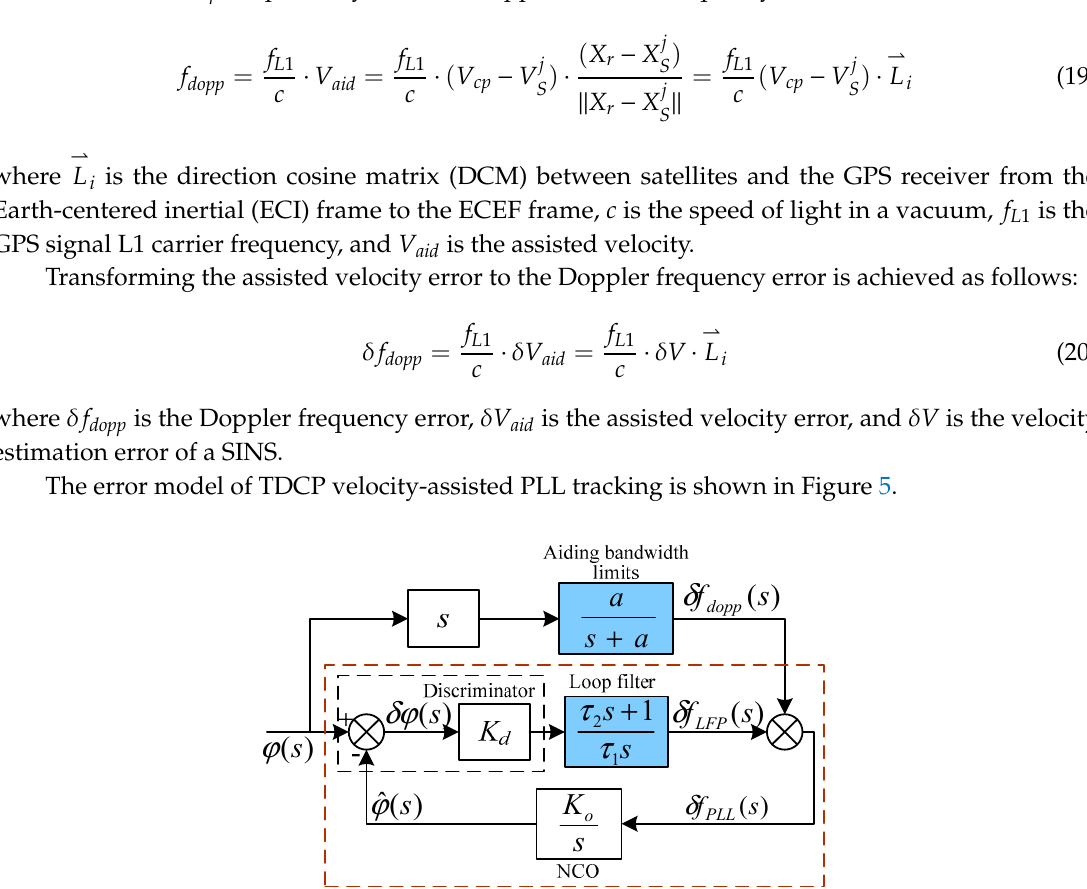
Figure 4. Configuration of TDCP velocity-assisted PLL tracking. NCO: numerically controlled